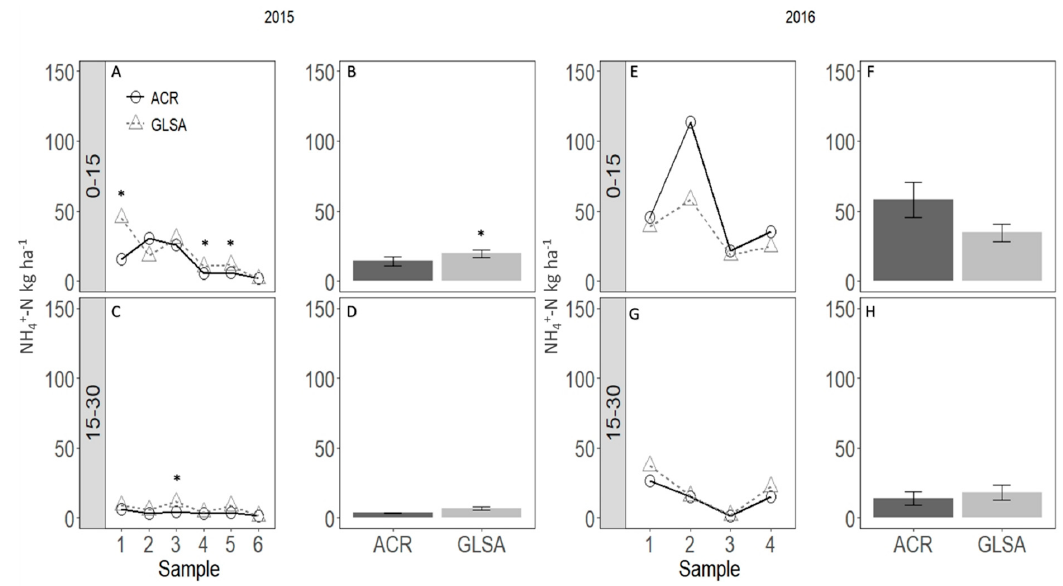
Figure 2. Average soil ammonium (NH 4 + -N) in 2015 from fields with annual crop rotations (ACR) and following a 3-year grassland set-aside (GLSA) at the 0–15 cm depth by sampling time ( A ) and seasonal average ( B ) and at the 15–30 cm depth by sampling time ( C ) and seasonal average ( D ); average soil ammonium (NH 4 + -N) in 2016 from fields with ACR and following a 3-year GLSA at the 0–15 cm depth by sampling time ( E ) and seasonal average ( F ) and at the 15–30 cm depth by sampling time ( G ) and seasonal average ( H ). Error bars represent one standard error of the mean (n = 4). Significant di ff erences are indicated by * ( p <